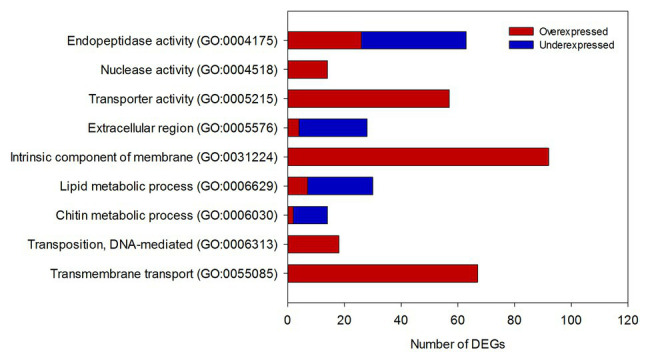
Distribution of differentially expressed genes (DEGs) among the gene ontology (GO) terms with the highest level in the gene ontology hierarchy. Color bars represent the pattern of gene expression in sugarcane-fed larvae compared to artificial diet-fed larvae. y-axis: GO Terms. DEGs, differentially expressed genes.